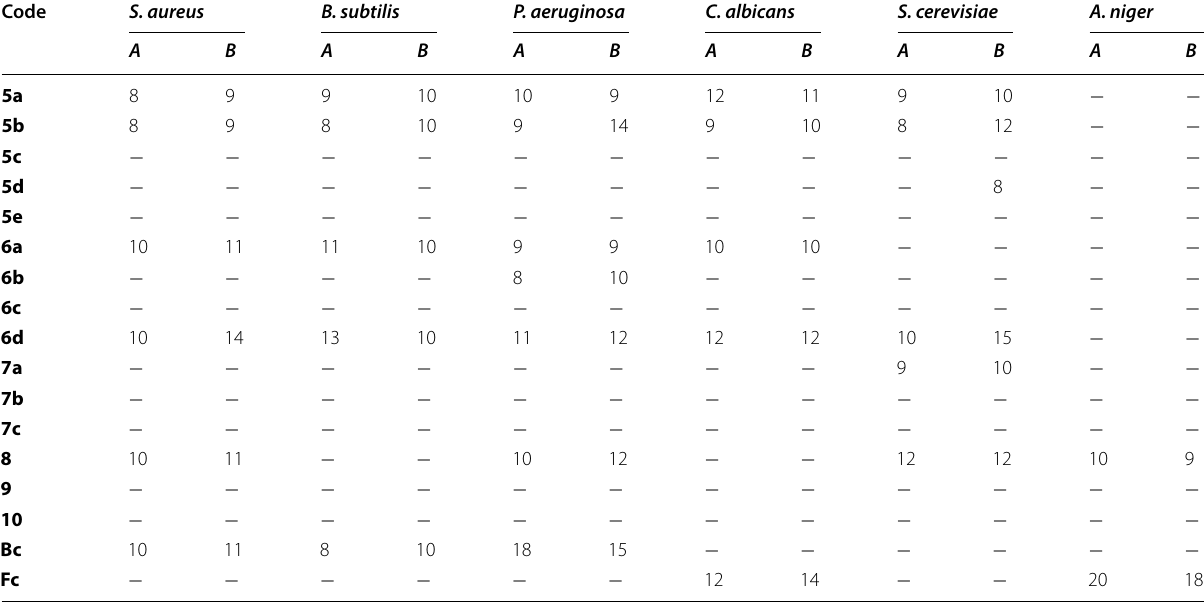
10 expressed as inhibition zone diameters (mm) −